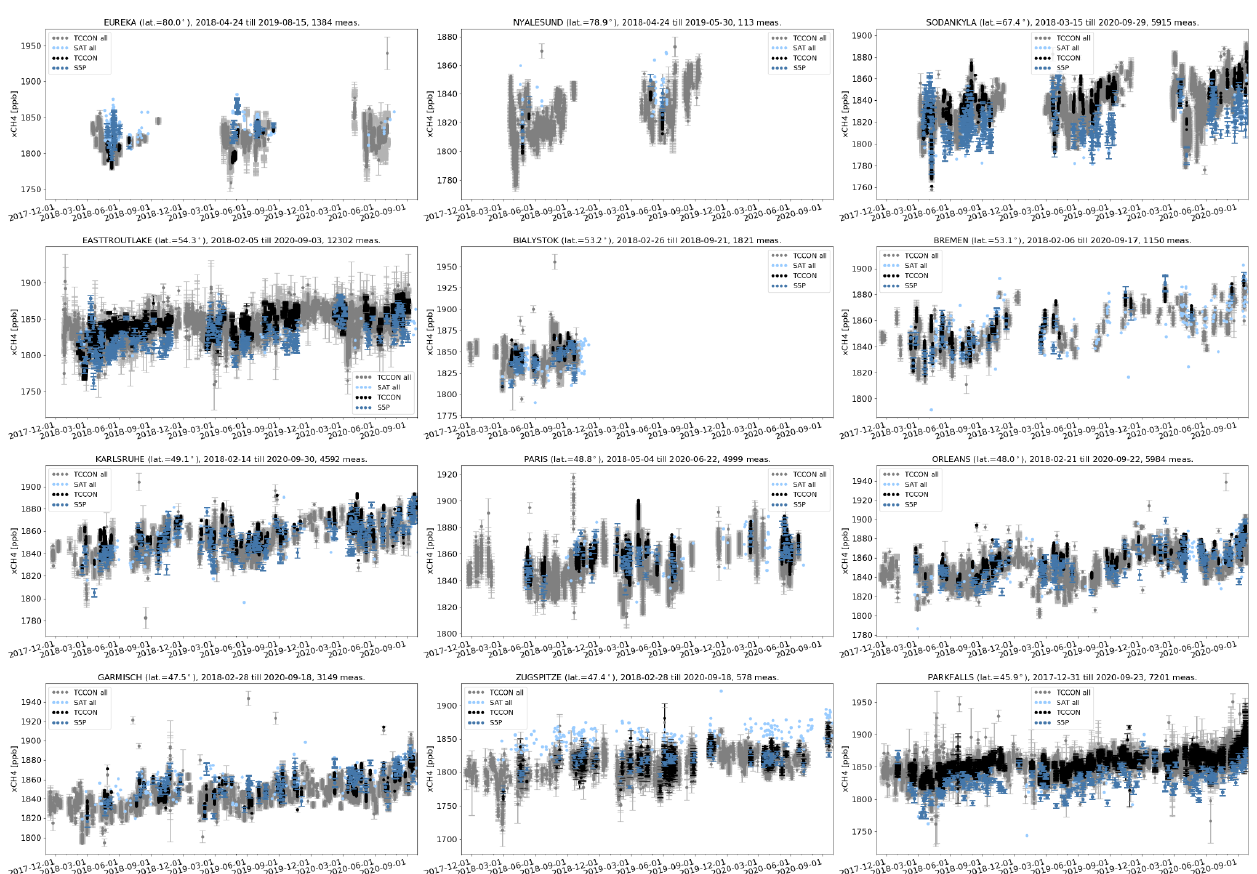
Figure 4. XCH 4 time series for all TCCON data (grey), S5P bias-corrected data (light blue), S5P data co-located with TCCON data (blue) and co-located TCCON data with a priori alignment (black) at each site ordered with decreasing latitude. Spatial co-location with radius of 100km and time of ± 1h around the satellite overpass was